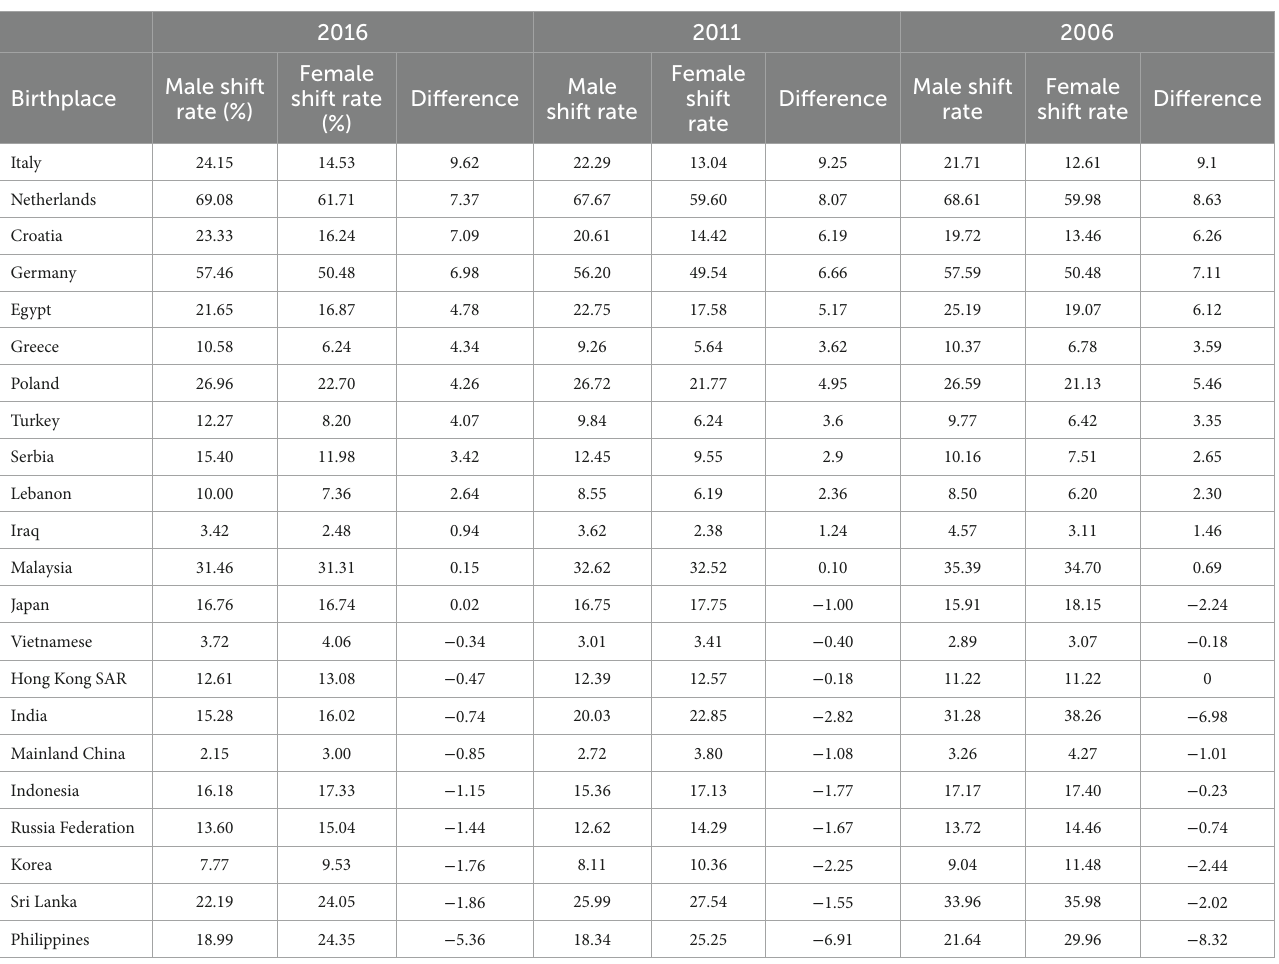
TABLE 6 Difference of the first-generation language shift rate by gender